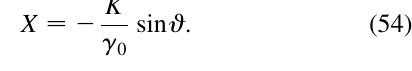
, with K ¼ 0 : 4 : opt